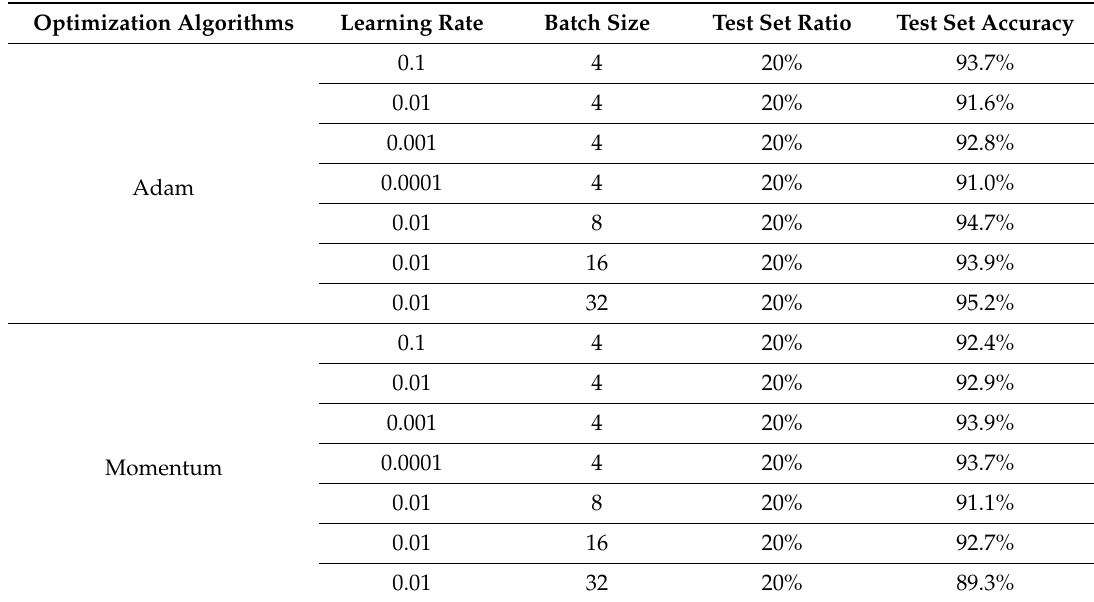
Table 3. Test result record during model